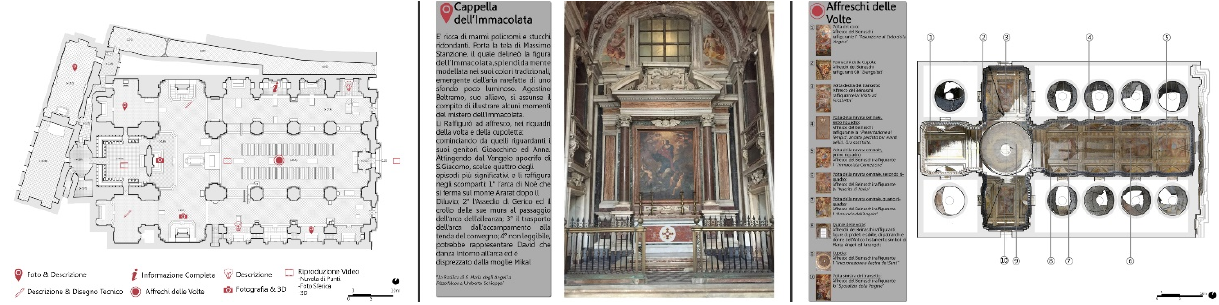
Figure 14. Virtual Tour of the Church of Santa Maria degli Angeli: detection of points of interest and visualization of the associated information